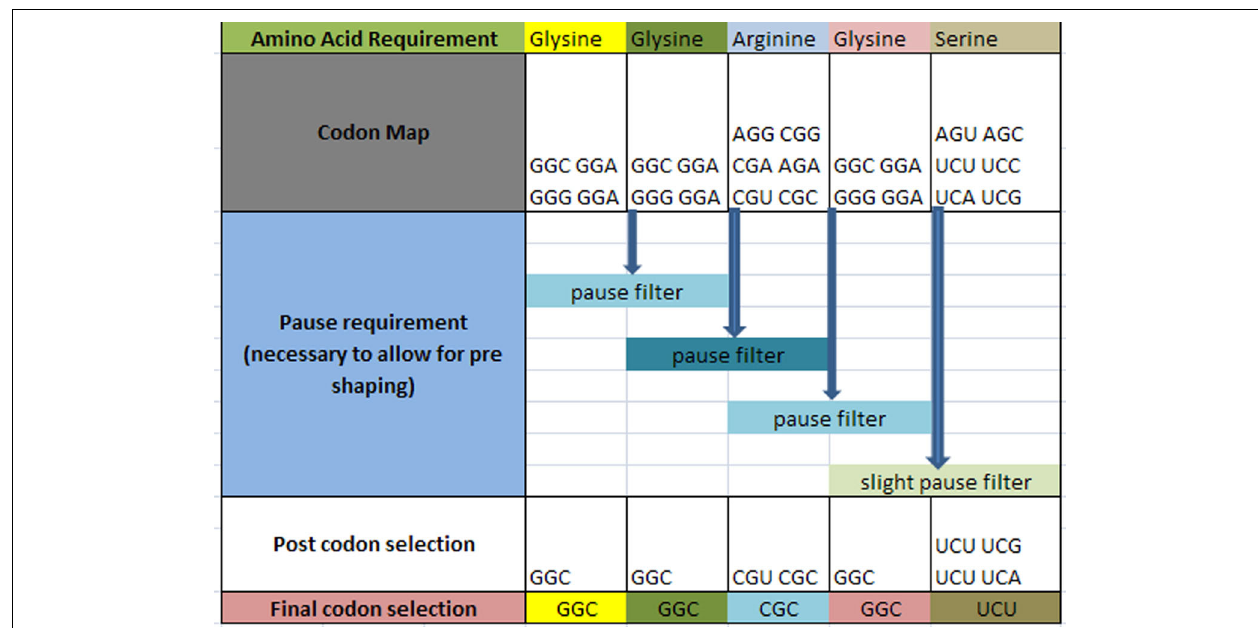
FIGURE 4 | Hypothetical amino acid/TP selection series example. Top row requires the given partial amino acid series for a given protein (left to right). The second row specifies the standard codon map for its particular amino acid. The pause requirement row specifies that a translation pause is necessary for the glycine to glycine junction, the glycine to arginine junction, arginine to glycine